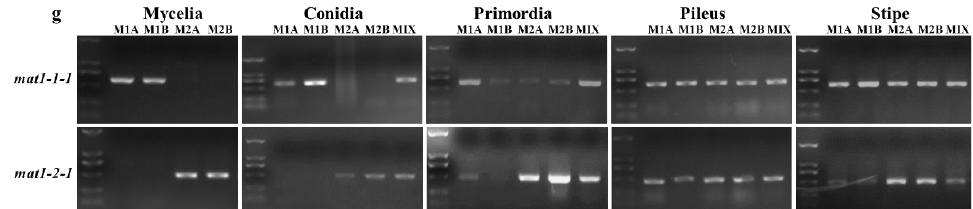
Figure 2. The sample collection and gene detection at different stages. ( a ) Samples of mycelia; ( b ) conidia, bar = 10 μm; ( c ) primordia; ( d ) fruiting body; ( e ) pileus, bar = 1 mm; and ( f ) stipe, bar = 1 mm. ( g ) The PCR results of mating-type genes of different samples at different stages. M1A and M1B are MAT1-1 type, M2A and M2B are MAT1-2 type, and MIX is spawned mixing MAT1-1 with MAT1-2 type strains.